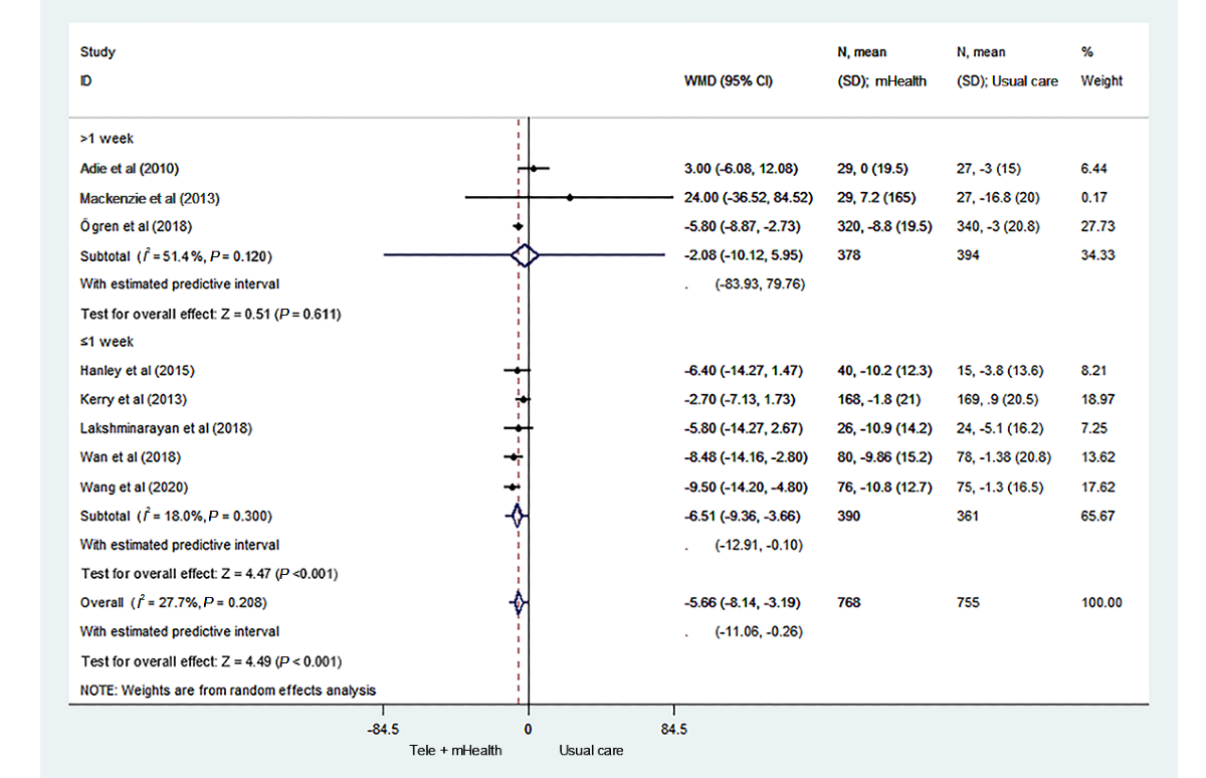
Figure 4. Forest plot of the subgroup analysis of the intervention interval. mHealth: mobile health; WMD: weighted mean difference.